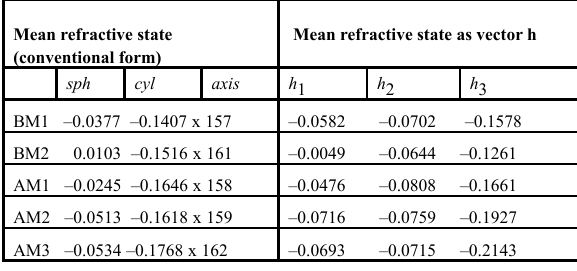
Table 1: The mean refractive state for each set of data measured by Gillan 1 is indicated. Sample size is the same (n = 30) in each case. BM1: Data collected 30 minutes prior to instillation of Mydriacyl into the right eye of the subject, BM2: Data collected immediately prior to instillation, AM1: Data collected 15 minutes after instillation, AM2: Data collected 30 minutes after instillation and AM3: Data collected 60 minutes after instillation. All quantities have units D, except for axis which is measured in degrees.